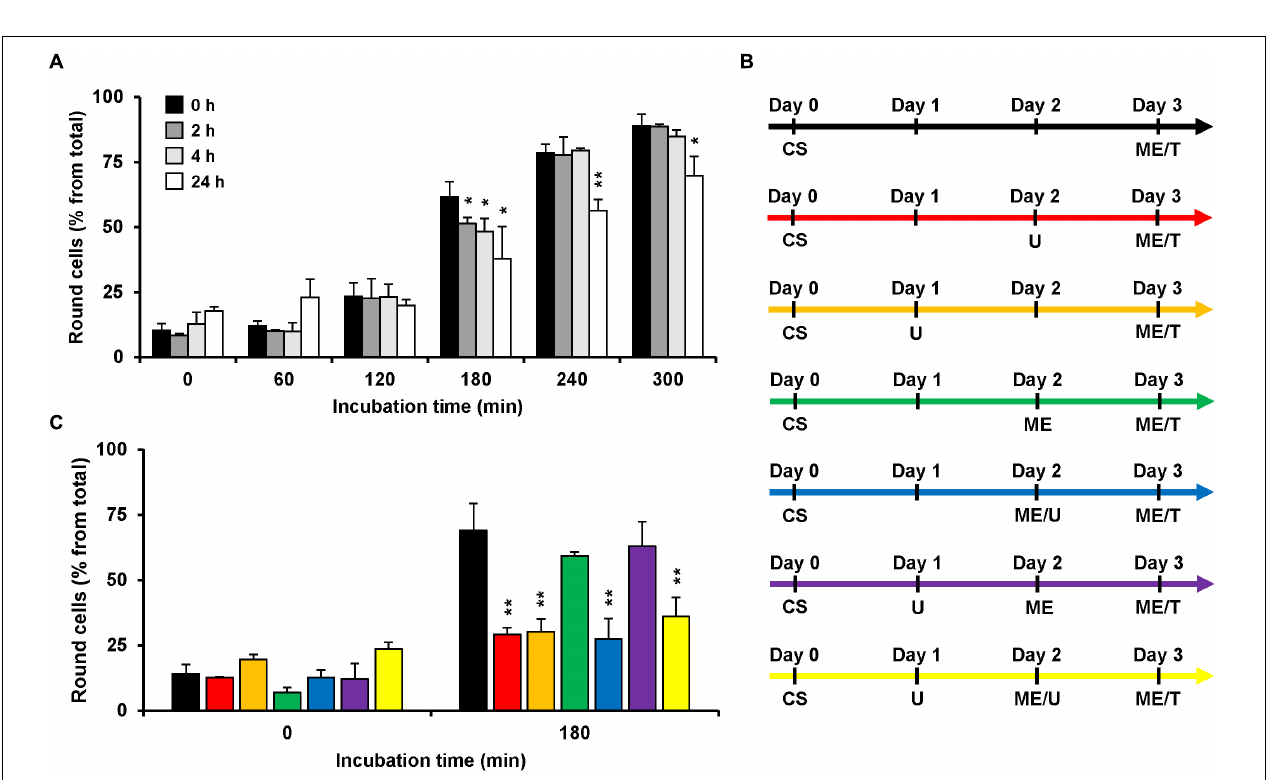
FIGURE 2 | Effect of U18666A preincubation conditions on the TcdB intoxicaton of HeLa cells. (A) HeLa cells were preincubated for 0 h (black bars), 2 h (dark gray bars), 4 h (light gray bars), and 24 h (white bars) with U18666A, followed by TcdB intoxication (10 pM) and microscopic analysis of TcdB-induced cell rounding over time. The bar chart shows mean percentages of round cells at the indicated incubation times after addition of the toxin. Error bars represent ± SD. Asterisks indicate statistical significance at each time point compared to control (black bar) with * p < 0.05 and ** p < 0.01. (B,C) The various U18666A pretreatment- and TcdB-intoxication conditions shown in (C) are schematically depicted with different colors in (B) . Cell seeding (CS) of HeLa cells at day 0 was followed by the addition of 10 µ M U18666A (U) at day 1 (orange, purple and yellow) and/or at day 2 without (red) or with medium exchange (ME; blue, yellow) and TcdB intoxication (10 pM) by medium exchange (ME/T) at day 3. The bar chart in (C) shows the percentages of round cells at the indicated incubation times after addition of the toxin. Error bars represent ± SD. Asterisks indicate statistical significance at each time point compared to control (black bar for red and orange bar; green bar for blue, purple and yellow bar) with ** p < 0.01. In all cases, data was obtained in three parallel experiments performed in independent